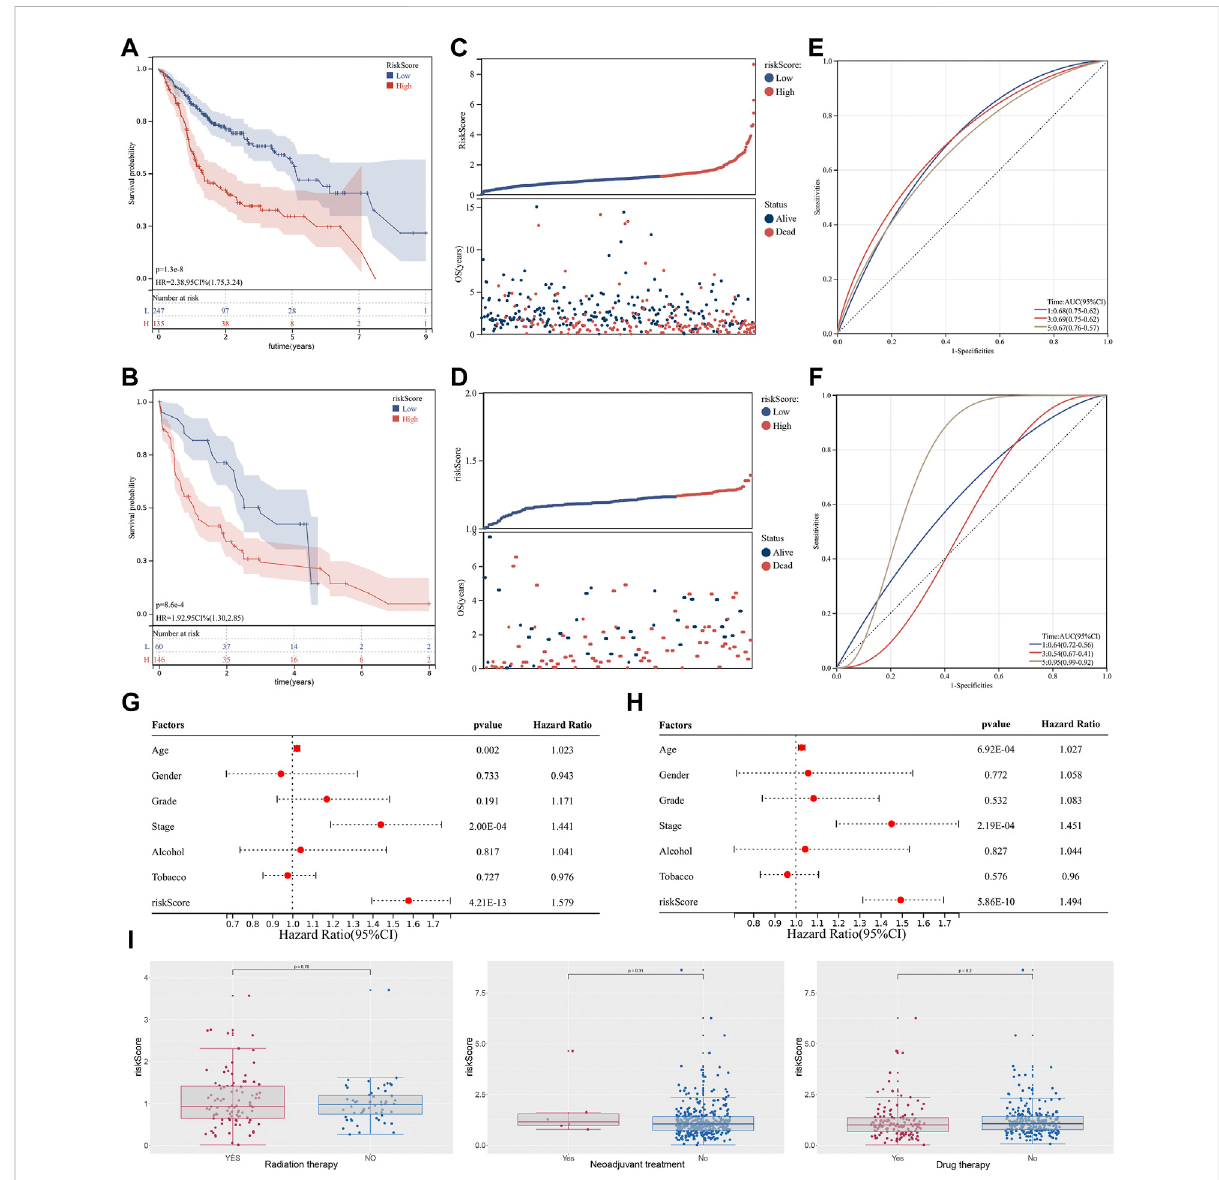
FIGURE 3 Identi fi cation of cuproptosis-related lncRNA based prognostic signature. Notes: (A , B) Kaplan-Meier curve analysis of the signature between twogroupsinbothtrainingcohortandvalidationcohort. (C , D) Intheriskplot,themortalityrateofpatientsdramaticallyincreasedwithanincreasein riskcore. (E , F) Time-dependent ROC curve analysis of 1-,3- and 5 years in both training cohort and validation cohort. (G , H) Univariate and multivariatecoxregressionanalysisofbetweentheriskscoreandclinicalfeaturesofthesignature. (I) Differentialexpressionanalysisofriskscore in patients with different treatments